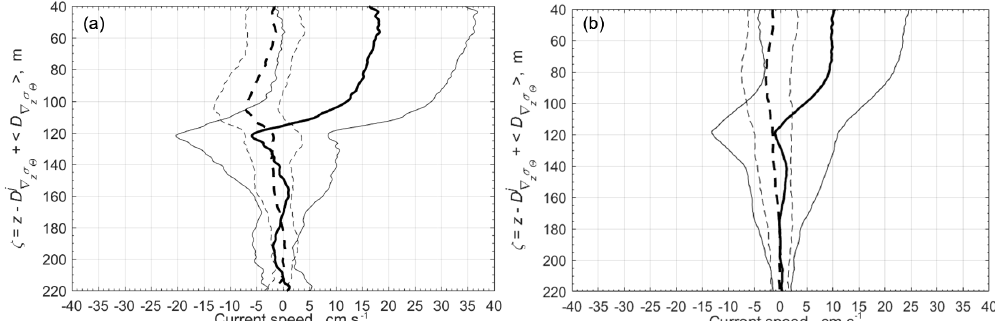
Figure 12. Depth profiles of along-shelf (NW direction is positive; solid curve) and cross-shelf (NE direction is positive; dashed curve) current speed components, which are derived from the ensemble of profiles when I σ 14 < 3 . 5molm − 2 (a) and when I σ 14 ≥ 3 . 5molm − 2 (b) from January to March 2016. The thick curves show the mean profiles, while the thin curves indicate standard deviations.